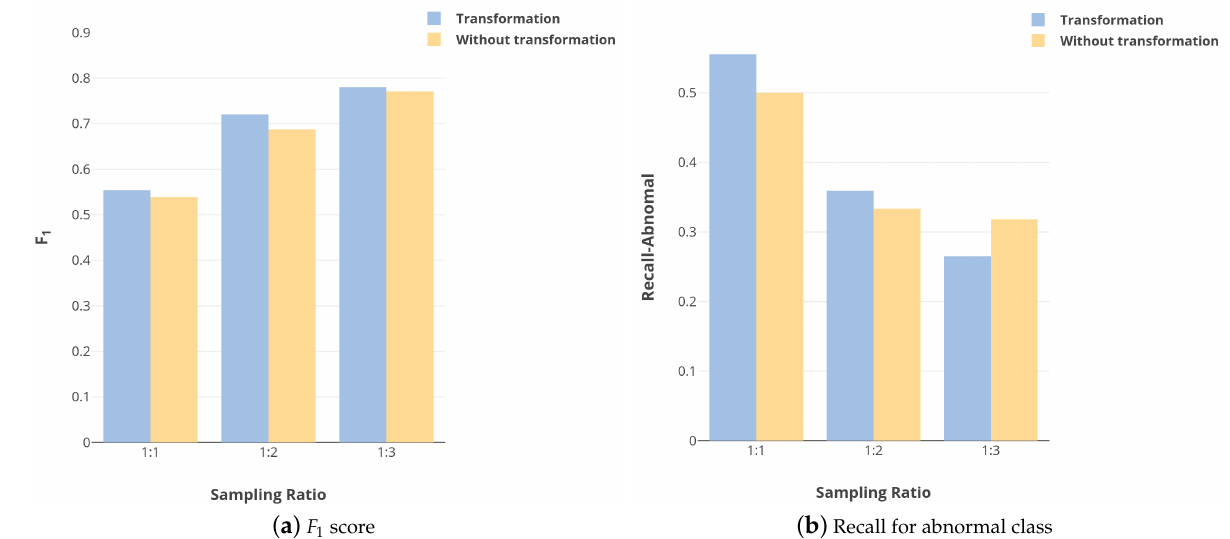
Figure 7. Effects of multiscale transformation on classification